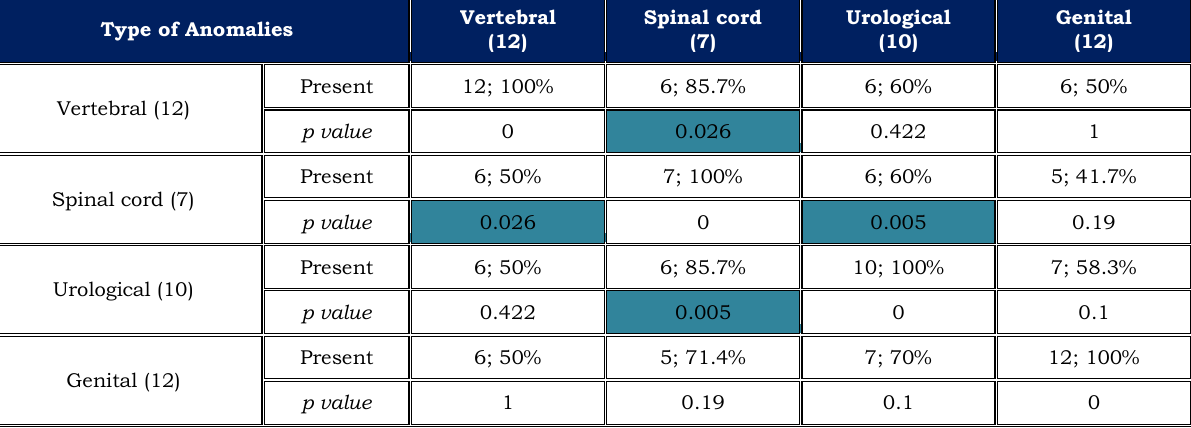
Table 4: Interrelationship between different associated anomalies in ARM patients based on two tailed fisher exact test. Boxes showing significant association shown in blue.